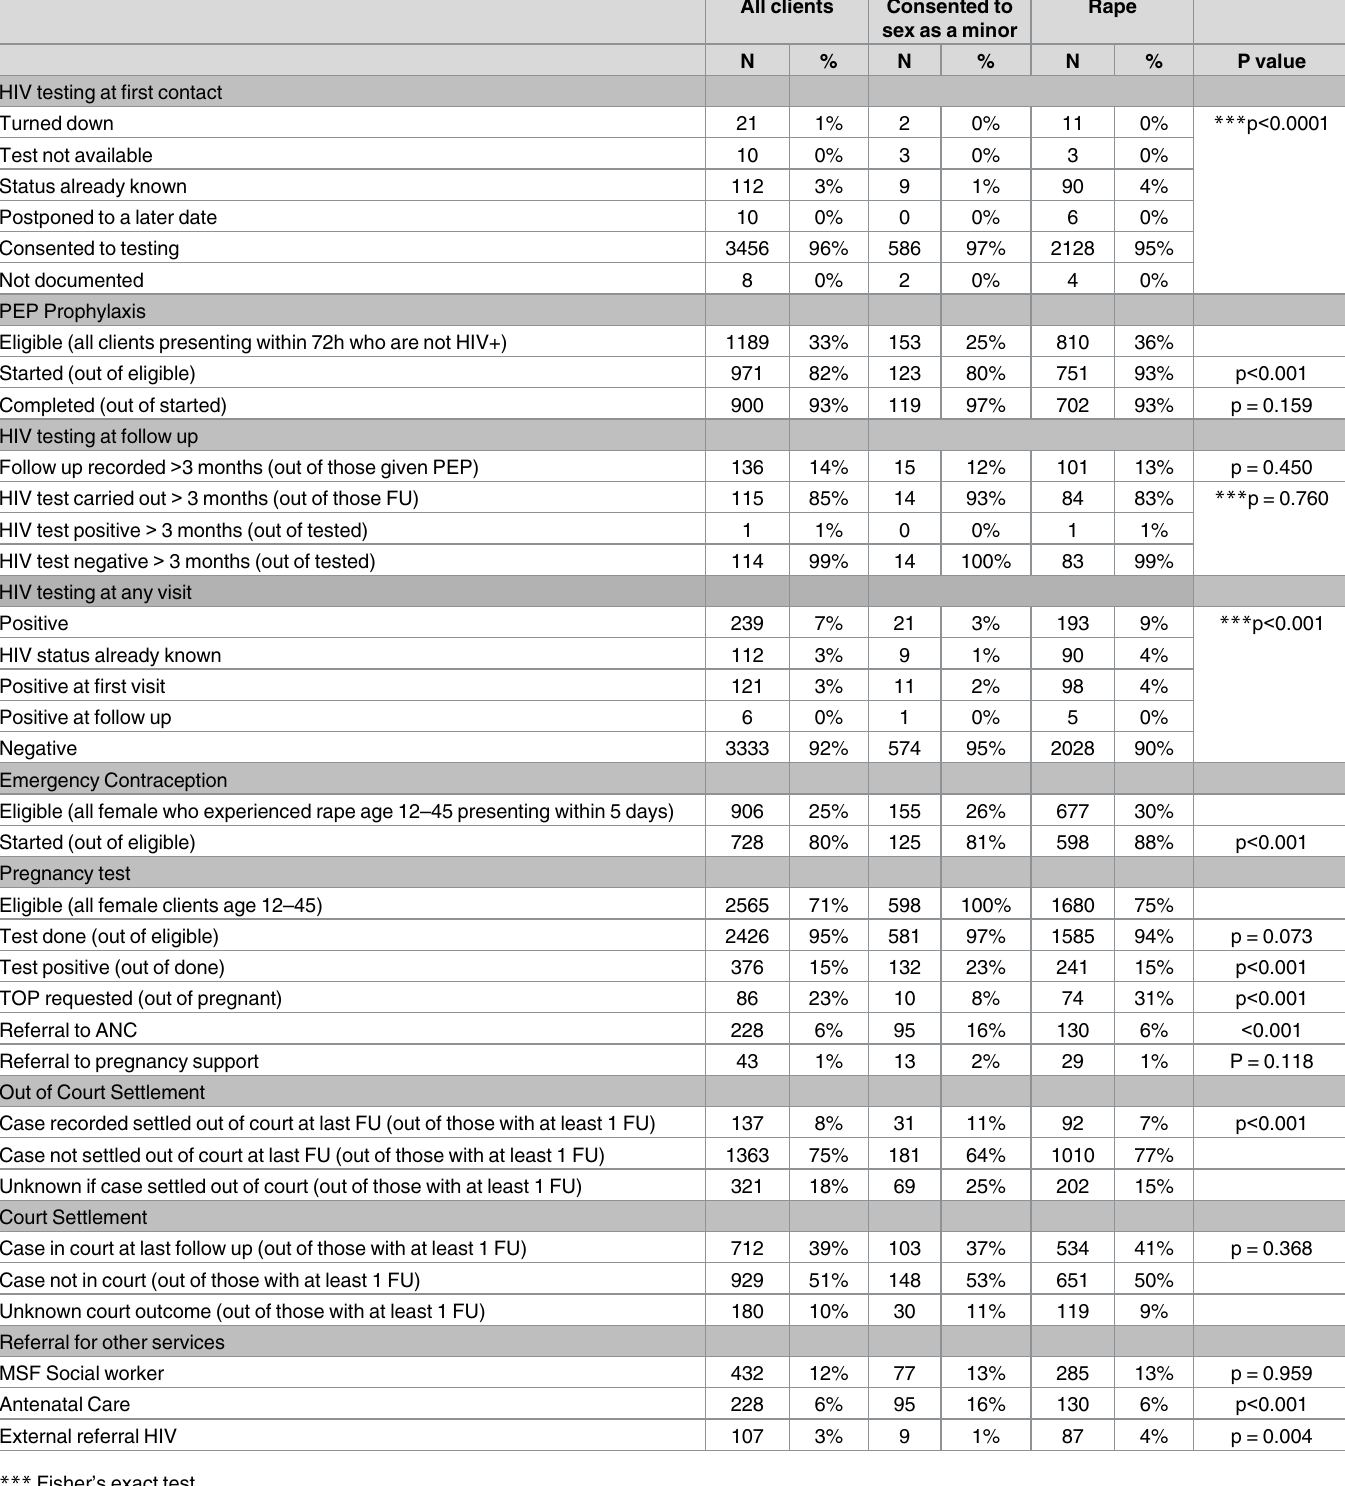
Table 4. Medical-legal management Mbare SGBV clinic